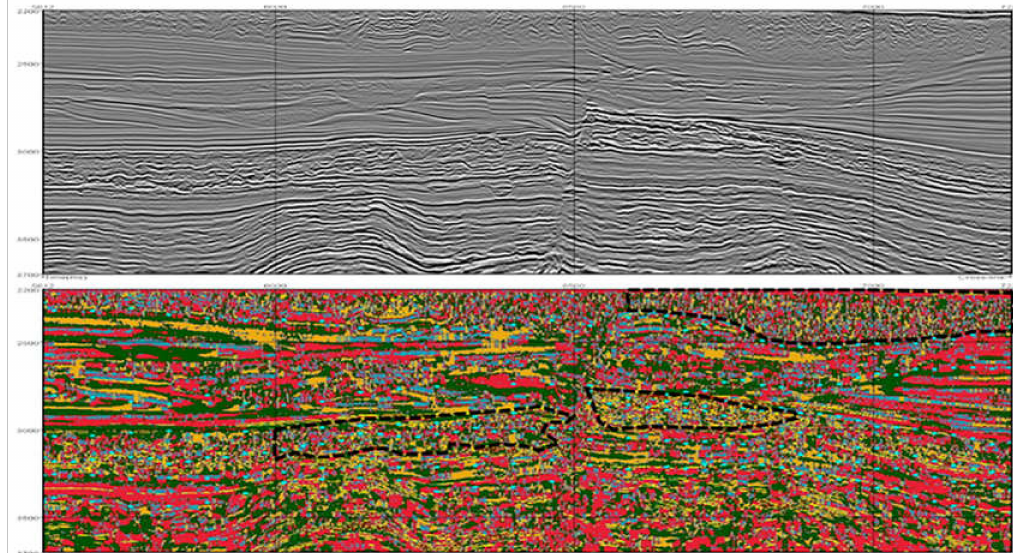
Figure 12. Results of the application of Kohonen on the best subset of seismic attributes and the Amplitude attribute with a rectangular map of size 6 × 6 neurons and 8 groups. The original vertical seismic slice is presented at the top; on the bottom, each group from the Kohonen map is represented with a unique color. Black polygons indicate regions in which groups show a chaotic